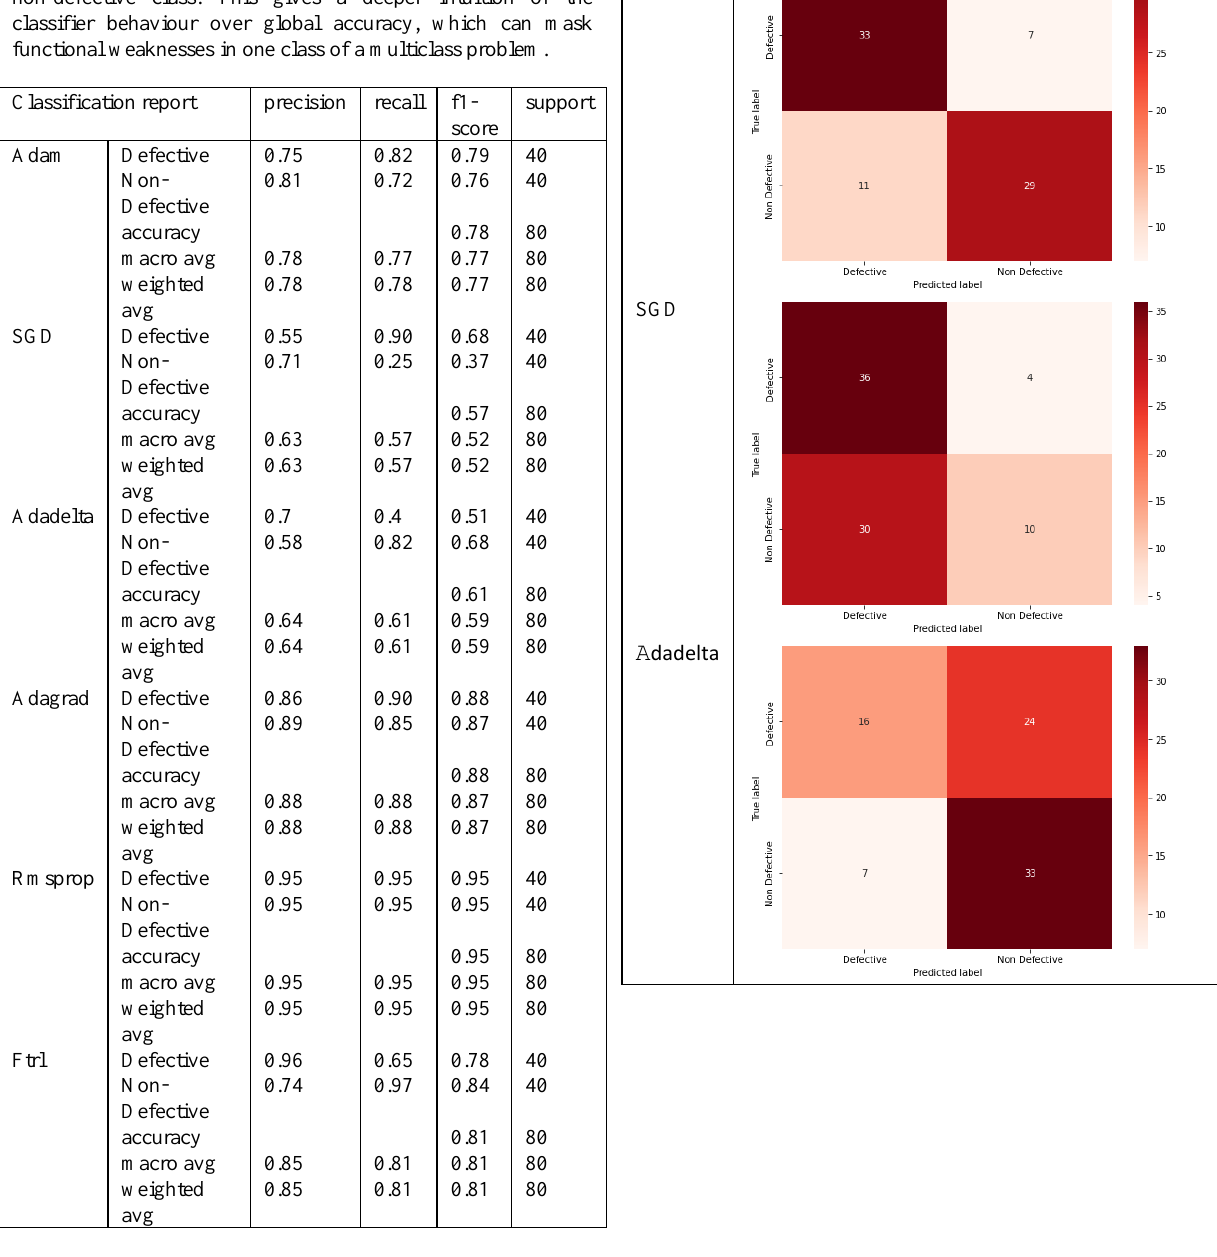
Table 4. Classification